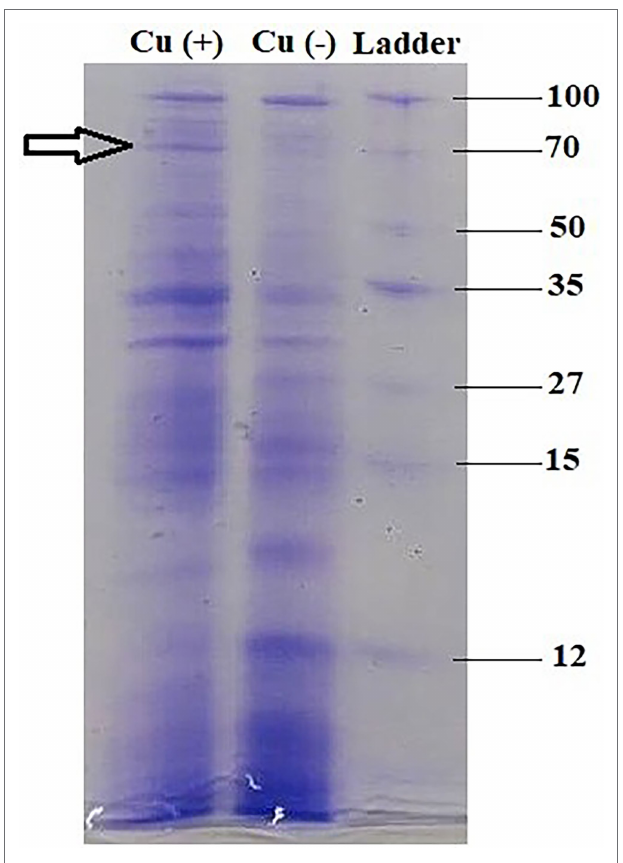
FIGURE 5 | Metallothionein profiling of B. altitudinis MT422188 via SDS- PAGE.